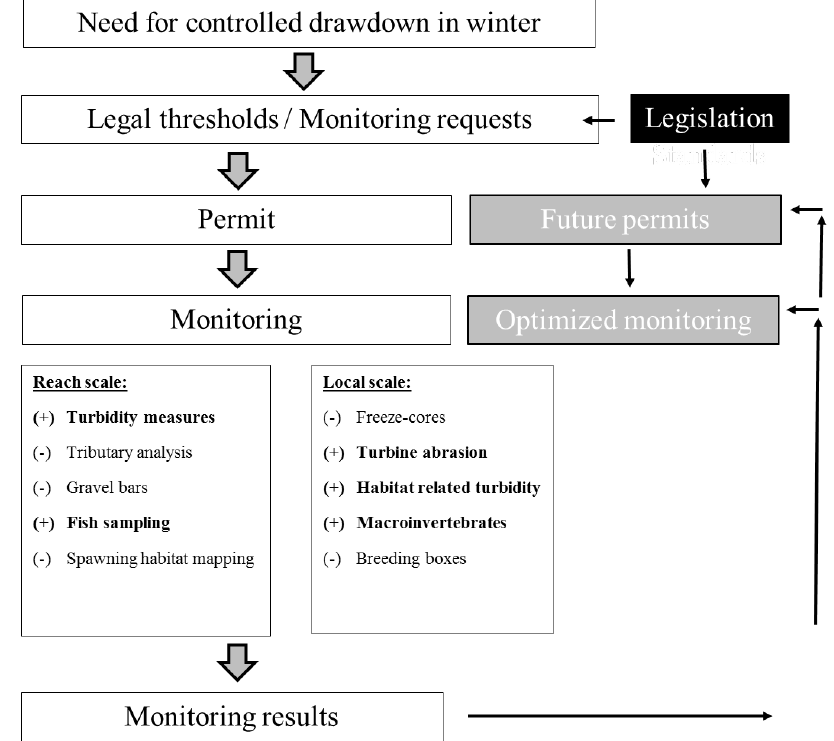
Figure 2. Flow chart for the controlled drawdown monitoring concept (CDMC) of the Gepatsch reservoir (white boxes) and the drawback of the conducted research for future permits and definition of optimized monitoring strategies (gray boxes). The role of governmental actions is presented in the black box. ( + ) indicates factors that are important for the ecological impact assessment in terms of a controlled reservoir drawdown and ( − ) indicates factors that are of minor importance for the ecological impact assessment in terms of a controlled reservoir drawdown.